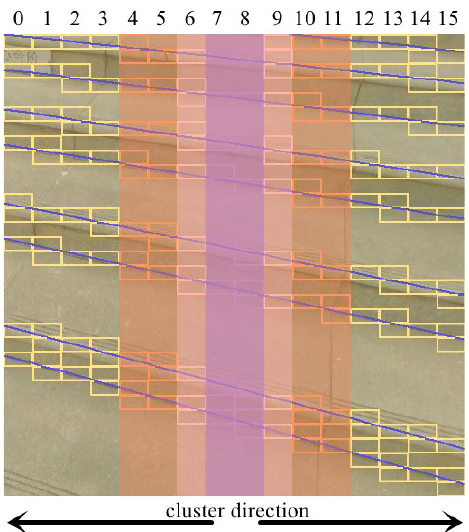
Figure 4. Illustration of stair line clustering based on the least squares method. Purple, pink, orange, and yellow represent the relevant areas of each